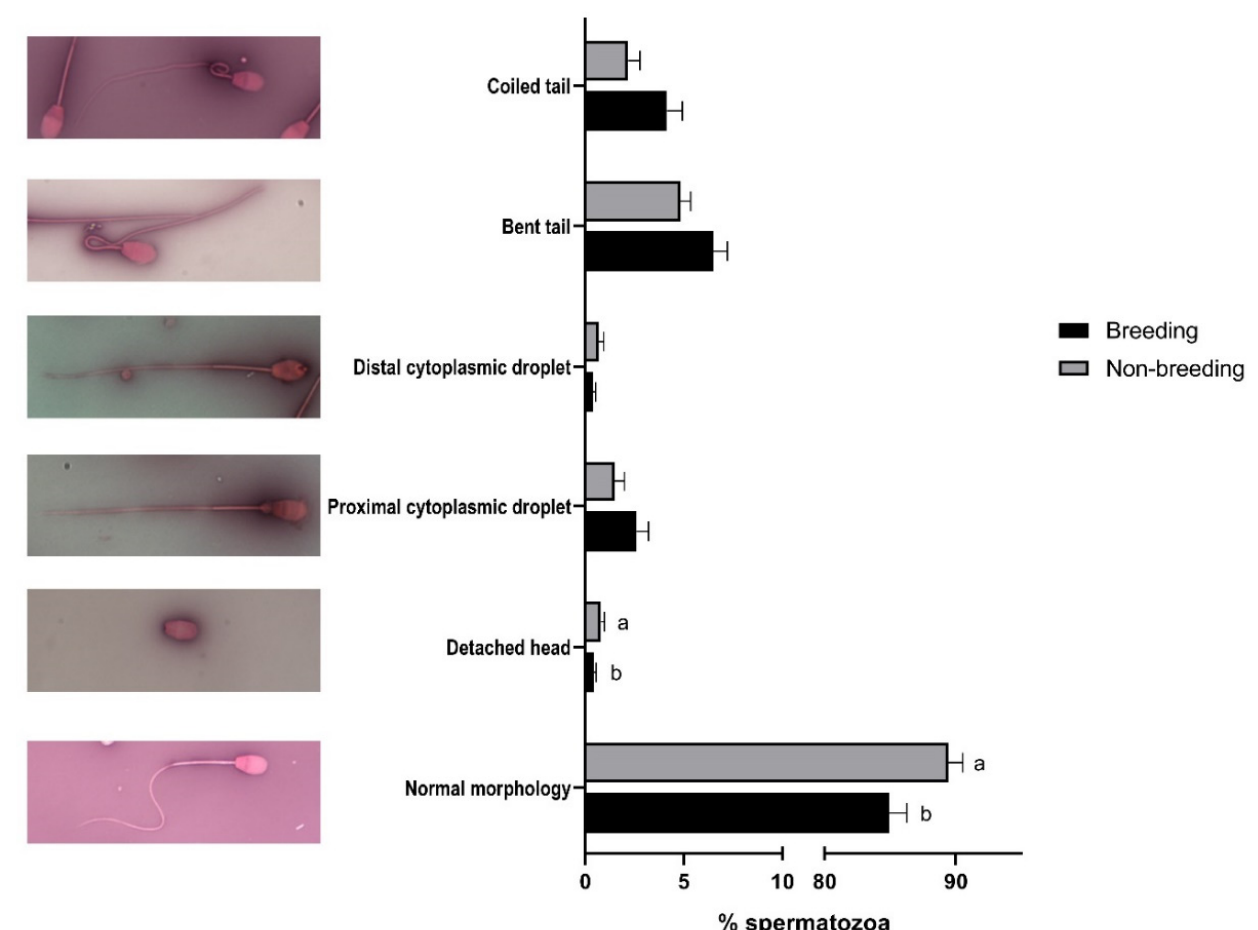
Figure 1. Seasonal differences in sperm morphology in Rasa Aragonesa rams. Results are shown as mean ± SEM of n = 56 (breeding season) and n = 40 (non-breeding season). Different letters indicate p < 0.05. Representative images of a normal spermatozoa and sperm abnormalities are also shown.